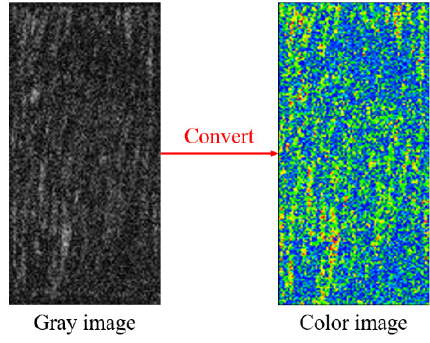
Figure 11. Conversion between gray image and color image.